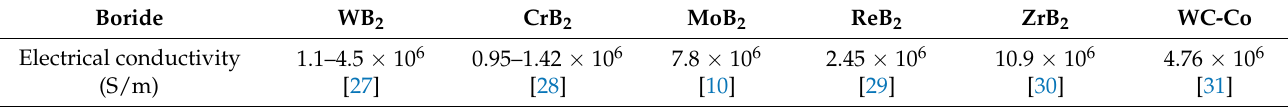
Figure 6. Electrical conductivity of W x TM x − 1 B 2.5 , (0 < x ≤ 0.24 TM = Cr, Mo, Re, Zr); samples spark plasma sintered at holding time 24 min. Table 3. Electrical conductivity of TM (TM = W, Cr, Mo, Re, Zr) diborides and tungsten